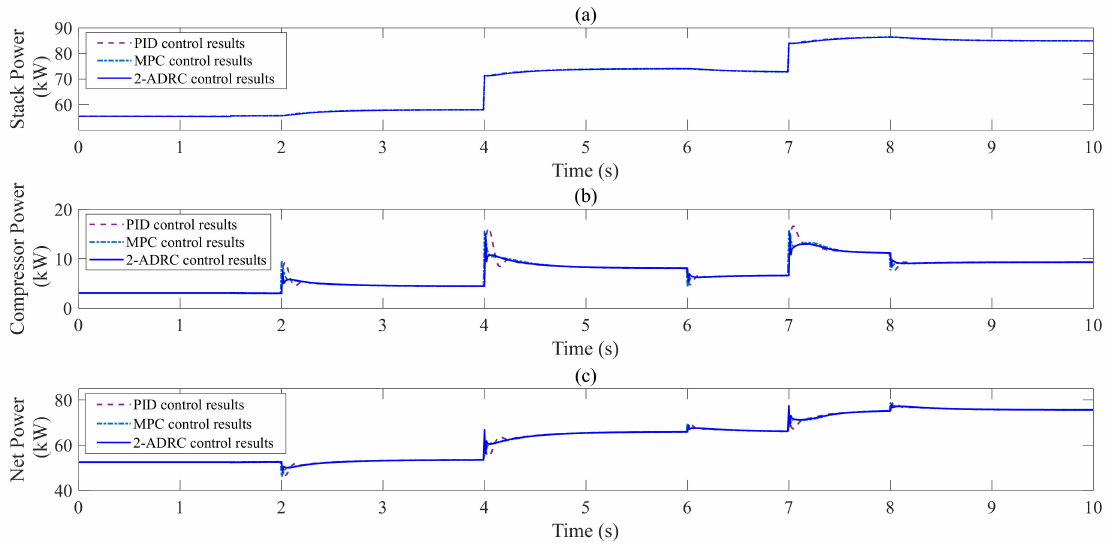
Figure 9. Power simulation results: ( a ) Stack power; ( b ) Compressor power; ( c ) Net power.